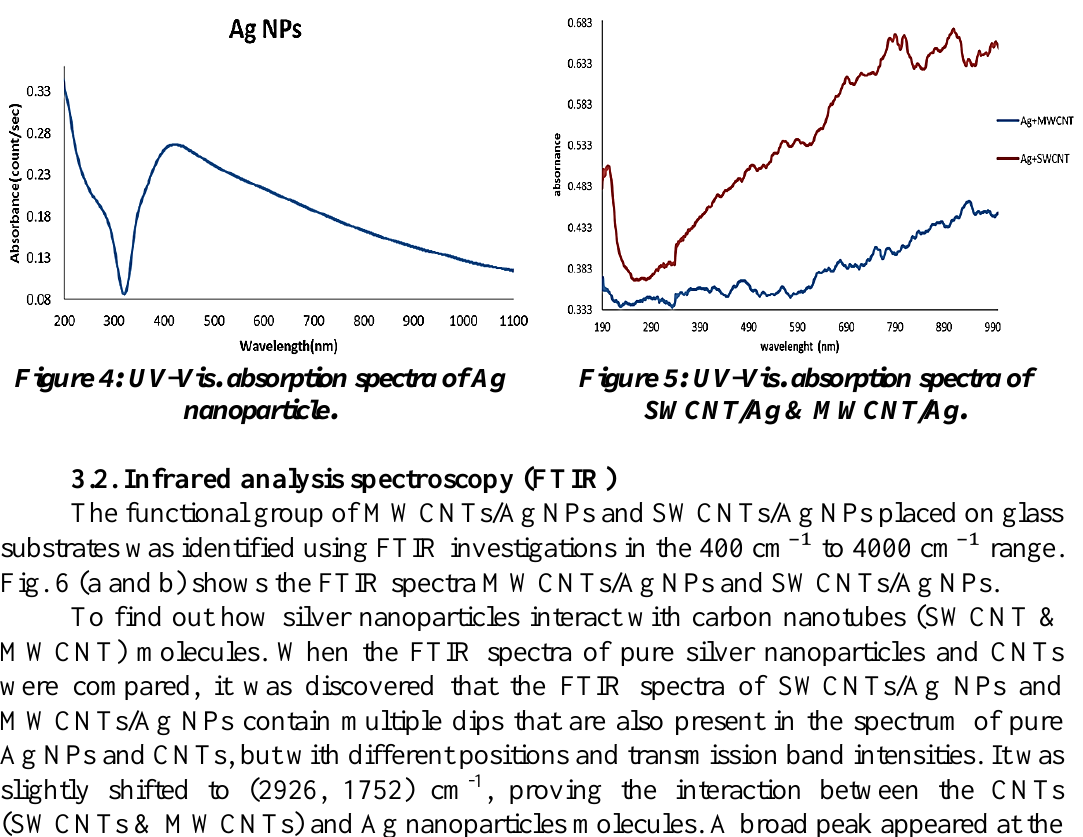
Figure 3: Schematic diagram of the experimental setup of photoconductive detector for I-V characteristics measurements.